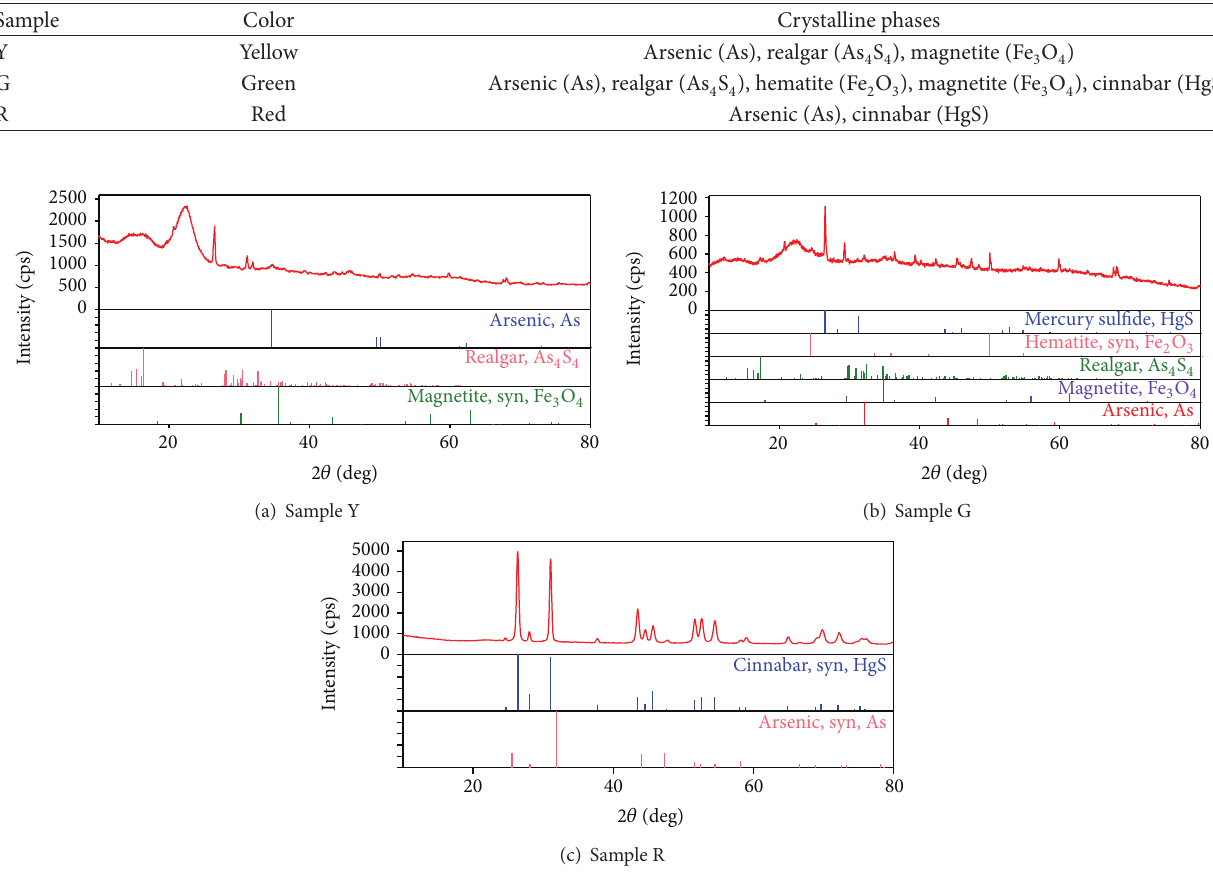
Table 3: Results of surface analysis by XRD.